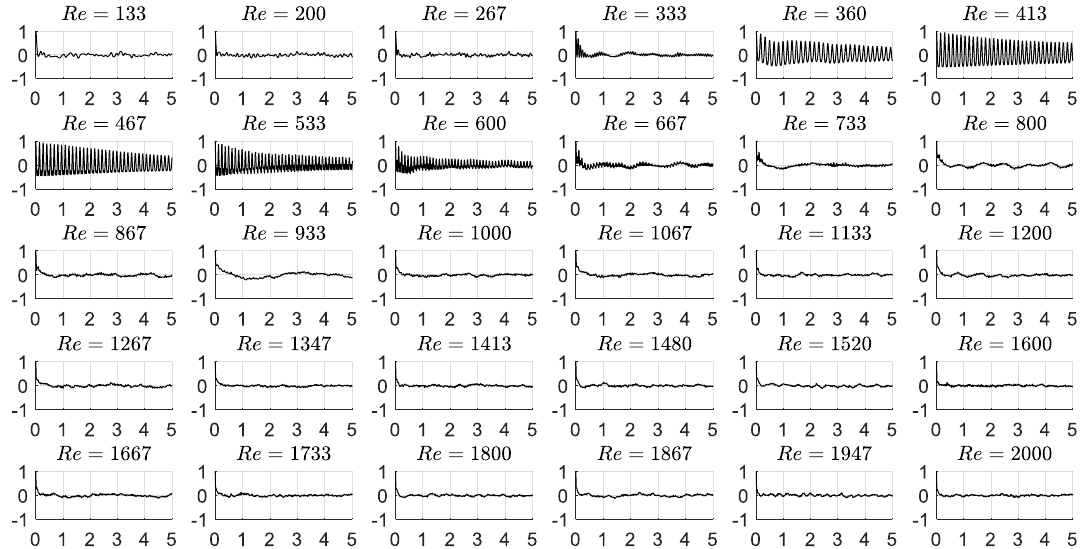
Figure 7. Trajectory of the free-end of Filament 1 as seen by an observer located downstream of the filament and facing the flow (Y-Z plane in Figure 2c).